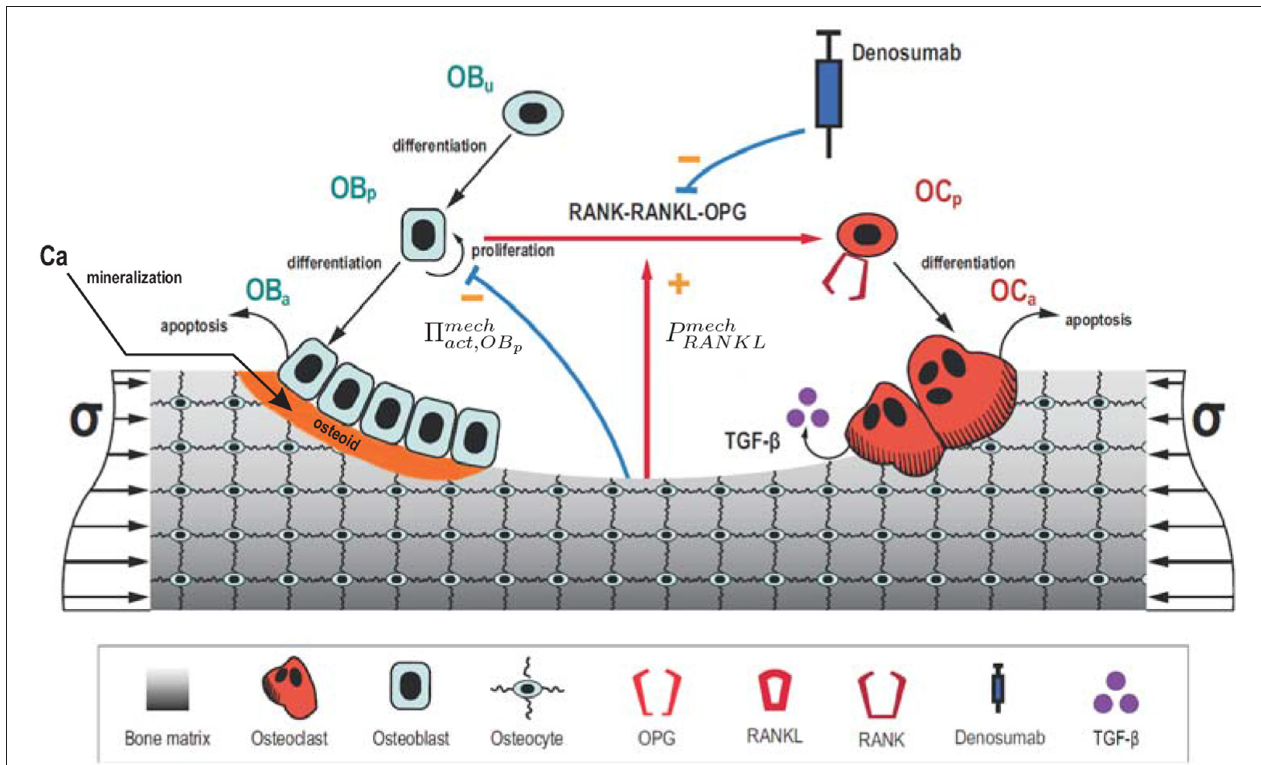
FIGURE 1 | Schematic representation of the mechanistic PK-PD model: bone cell differentiation stages along with biochemical and biomechanical interactions are presented. Subcutaneous injection of denosumab leads to distribution of the drug into the central compartment where it interacts with the RANK-RANKL-OPG pathway (red arrow between Ob p and Oc p ). The latter interactions are accounted for via competitive binding reactions. The mineralisation of osteoid is shown in